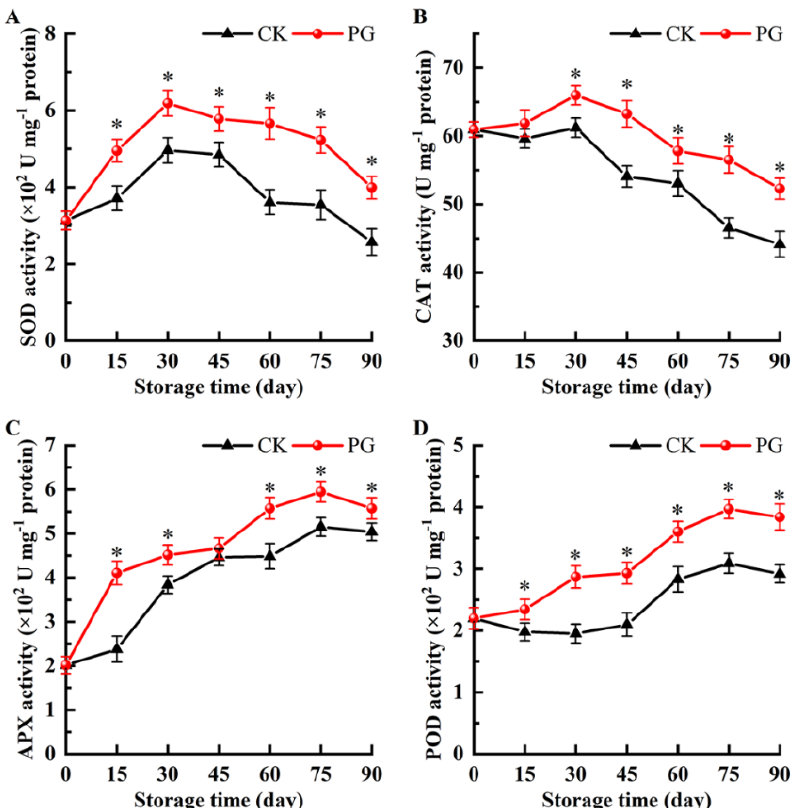
Figure 7. Effects of PG treatment on the activity of superoxide dismutase (SOD) ( A ), catalase (CAT) ( B ), ascorbate peroxidase (APX) ( C ), and peroxidase (POD) ( D ) in the peel. Vertical bars represent the SE of the mean. The asterisks indicate significant difference between two treatments during the same storage period (* p < 0.05).